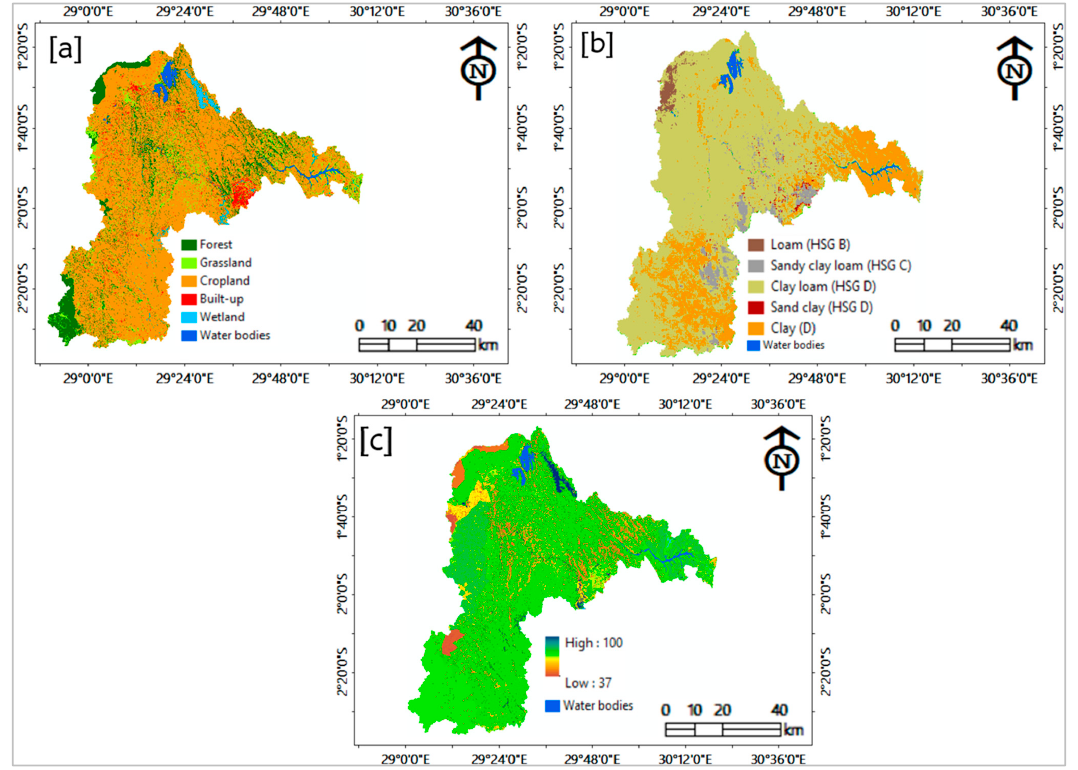
Water 2021 , 13 , x FOR PEER REVIEW Figure 2. ( a ) LULC, ( b ) soil properties and hydrological Soil Groups (HSG), ( c ) CNgrid.